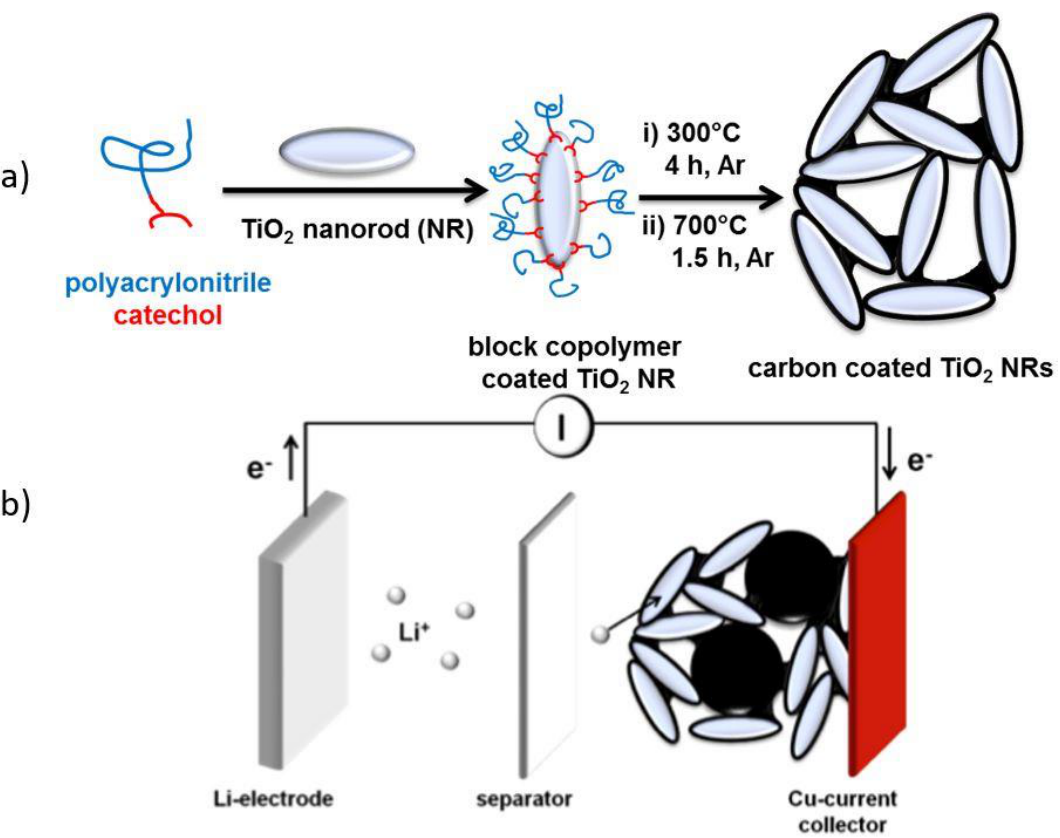
Figure 9. Coating of TiO 2 nano-rods with block copolymers with a graphitable polyacrylonitrile block and their conversion into a nanocomposite with nano-rods embedded in graphite [118] ( a ) and the use of this nanocomposite as anode ( b ); reproduced with permission of [118], published by Wiley-VCH, 2013.